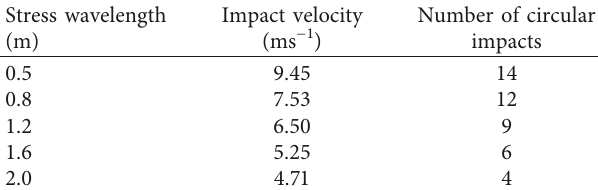
Table 2: Experimental parameters of circular